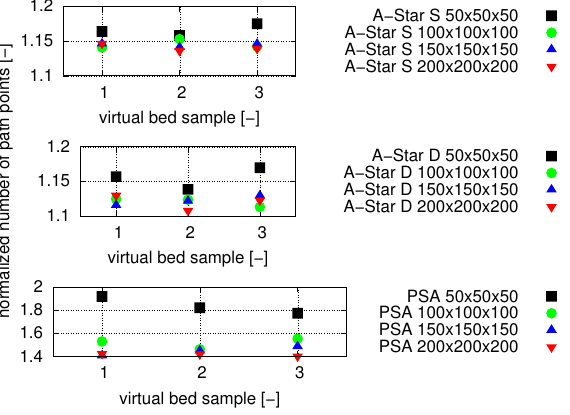
Figure 16. Normalized number of path points in the function of grid resolution and the algorithm